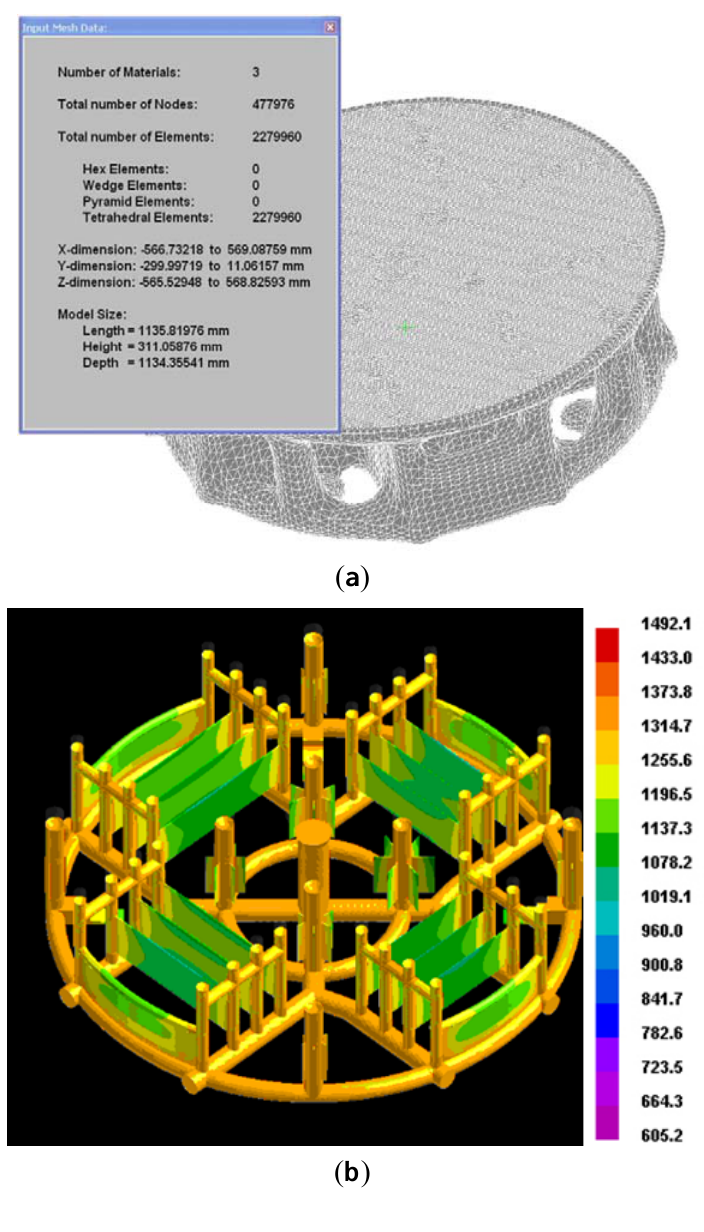
Figure 3. Finite element mesh and the temperature profile of the casting. ( a ) Digitized casting with shell; ( b ) Temperature